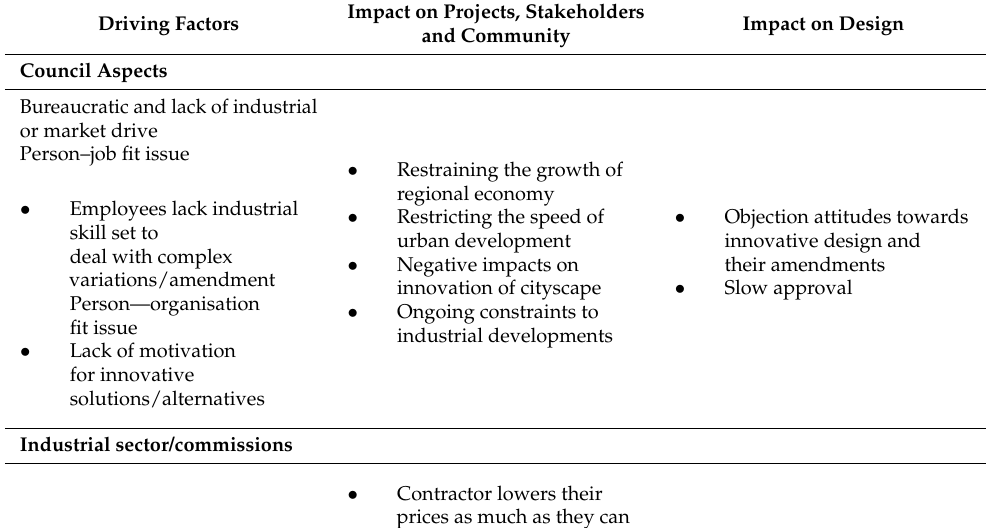
Table 4. Indirect factors affect design change